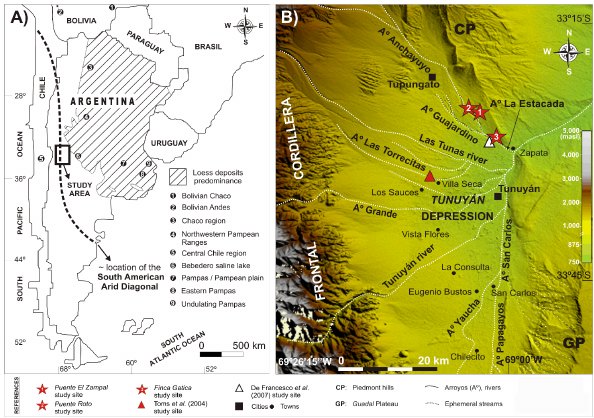
Fig. 1. (A) Location map. Approximate distribution of loess de- posits in Argentina (Zinck and Sayago, 1999) and extension of the South American Arid Diagonal. (B) Digital elevation model and flu- vial drainage at the eastern Andean piedmont between 33 and 34 ◦ S, Mendoza province,